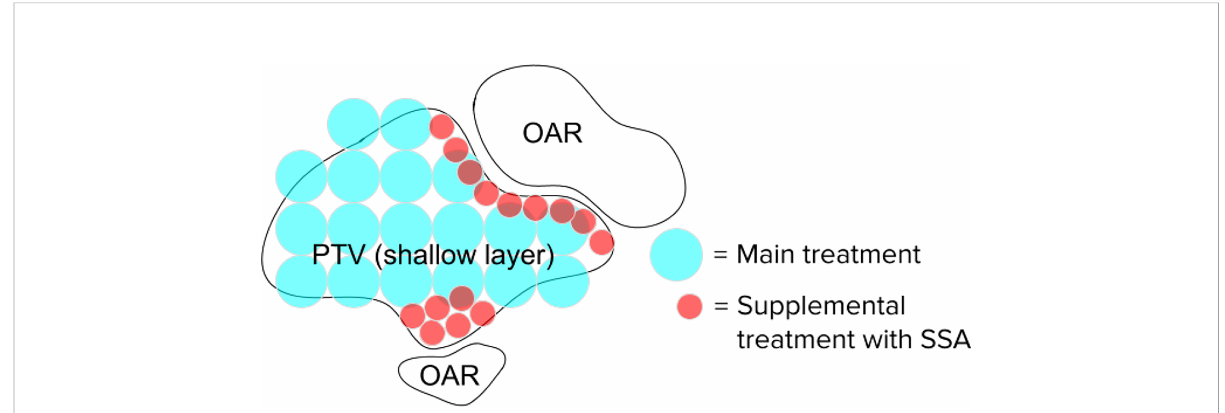
FIGURE 14 Hypothetical spot positions for a single layer, for the main treatment using conventional techniques and the supplemental spots using the SSA. The SSA could be moved out of place when not needed. This will signi fi cantly reduce the beam-on time and excess integral neutron